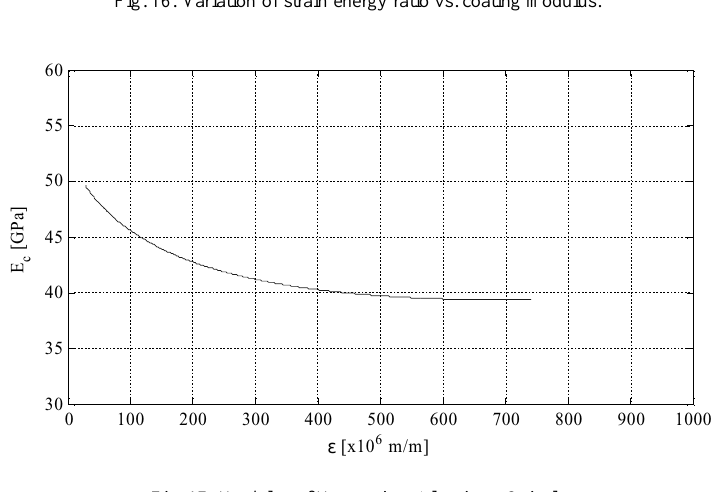
Fig. 17. Modulus of Magnesium Aluminate